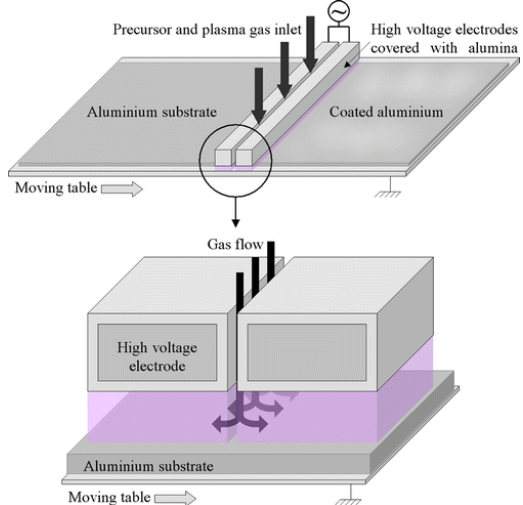
Figure 12. Schematic of an atmospheric pressure dielectric barrier discharge (DBD) device for large-area deposition of plasma-polymerized organosilicon thin films. Reproduced with permission from [86].